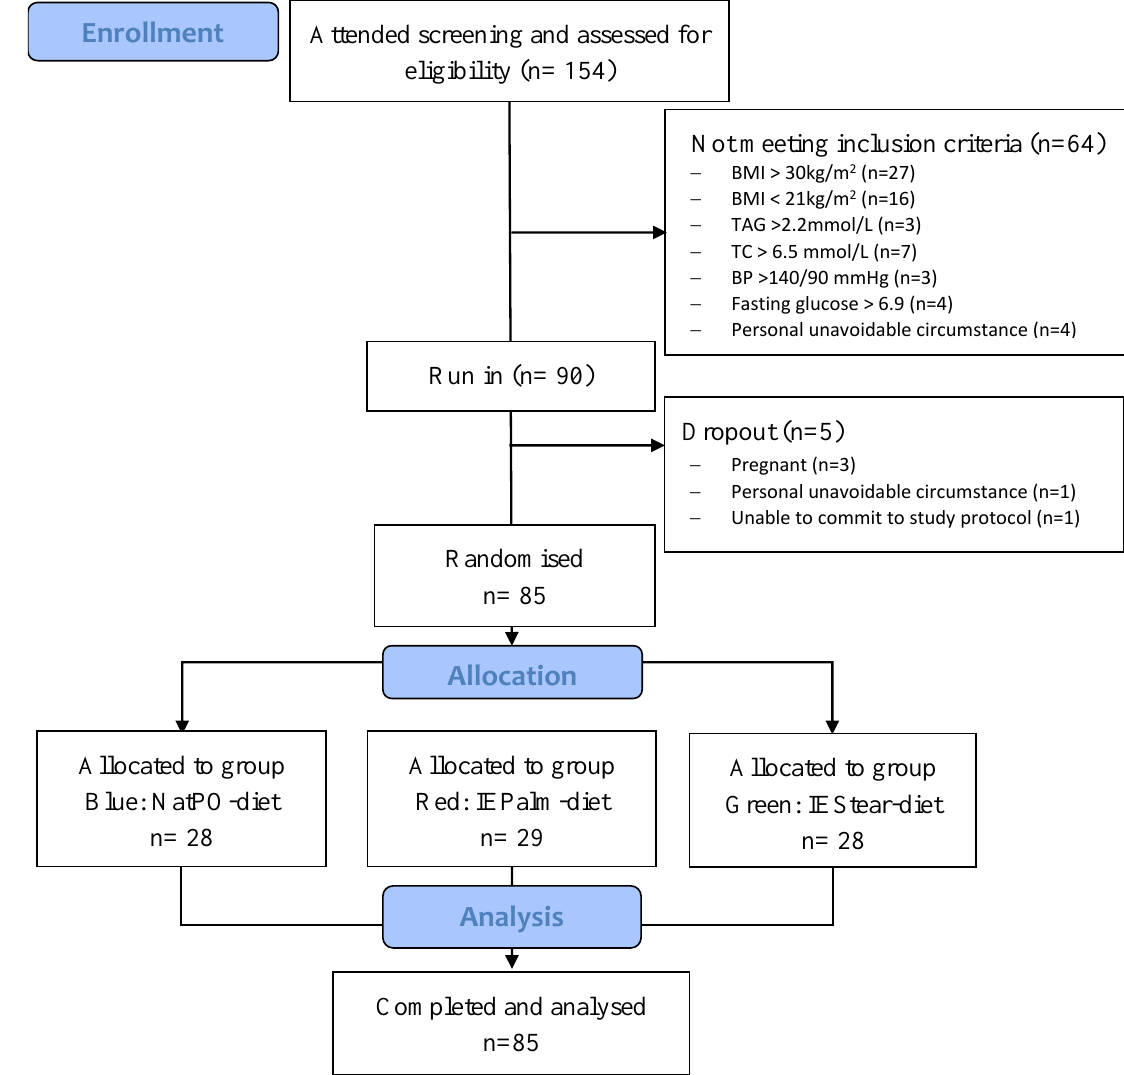
Figure 2. CONSORT flow diagram of subjects throughout the study.